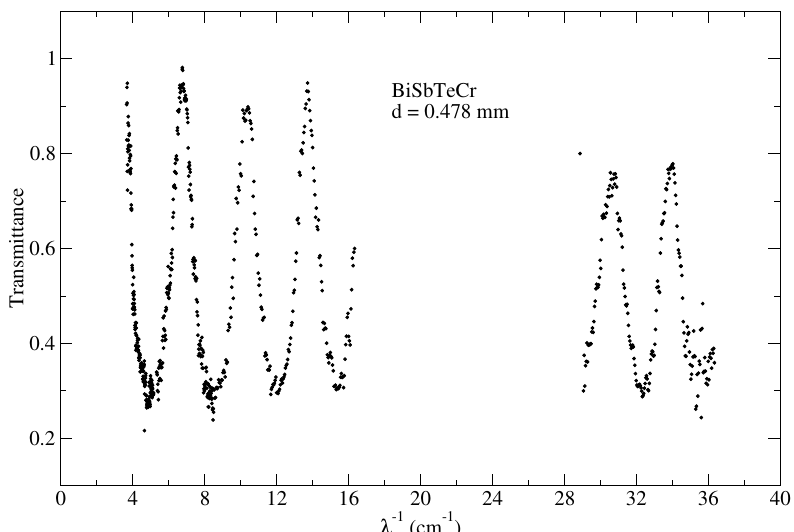
Figure 6. Transmittance spectrum of the sample used in this work in zero magnetic field and at temperature T = 1.85K. This spectrum was measured in the parallel polarizers geometry, t xx , and shows a series of Fabry-Pérot resonances due to reflections on the substrate